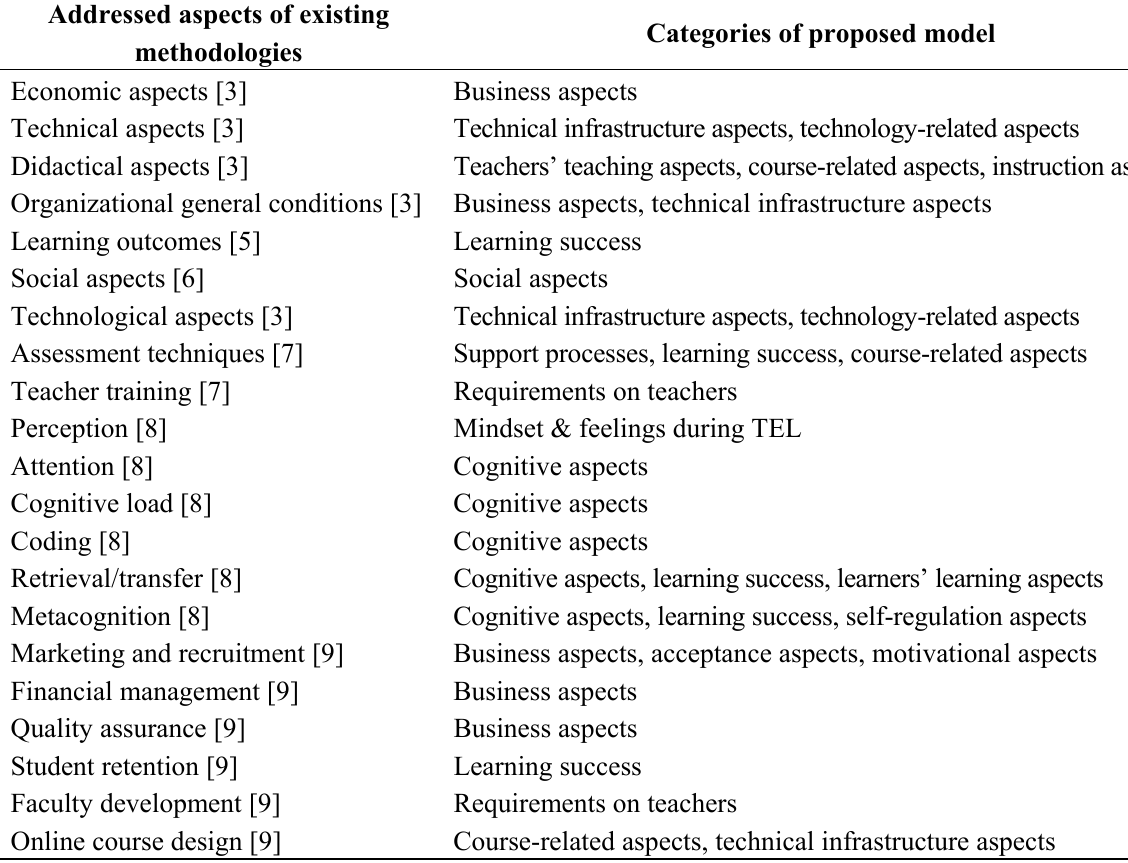
Table 3. Comparison of identified categories/aspects and addressed aspects of existing methodologies. Addressed aspects of